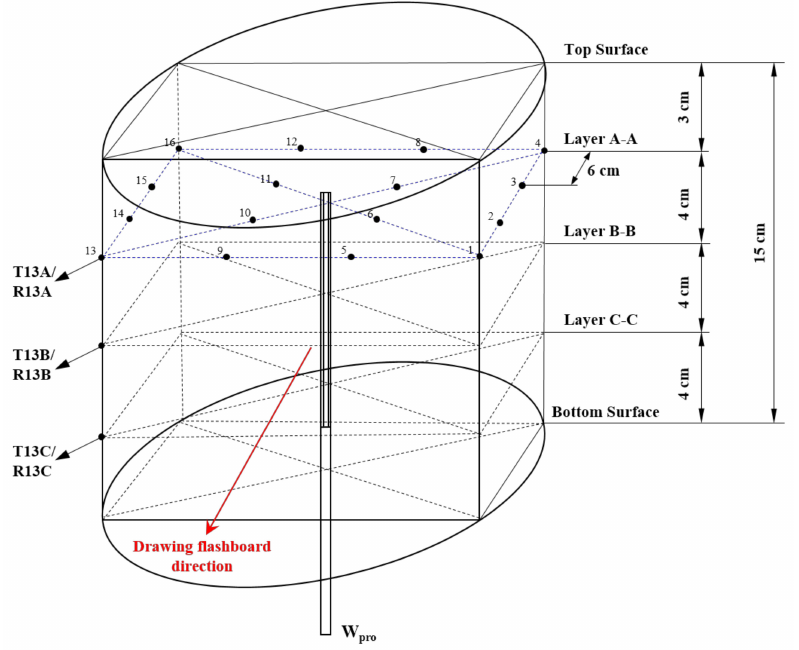
Figure 9. Temperature/electric resistance measurement points distribution and well configurations in the